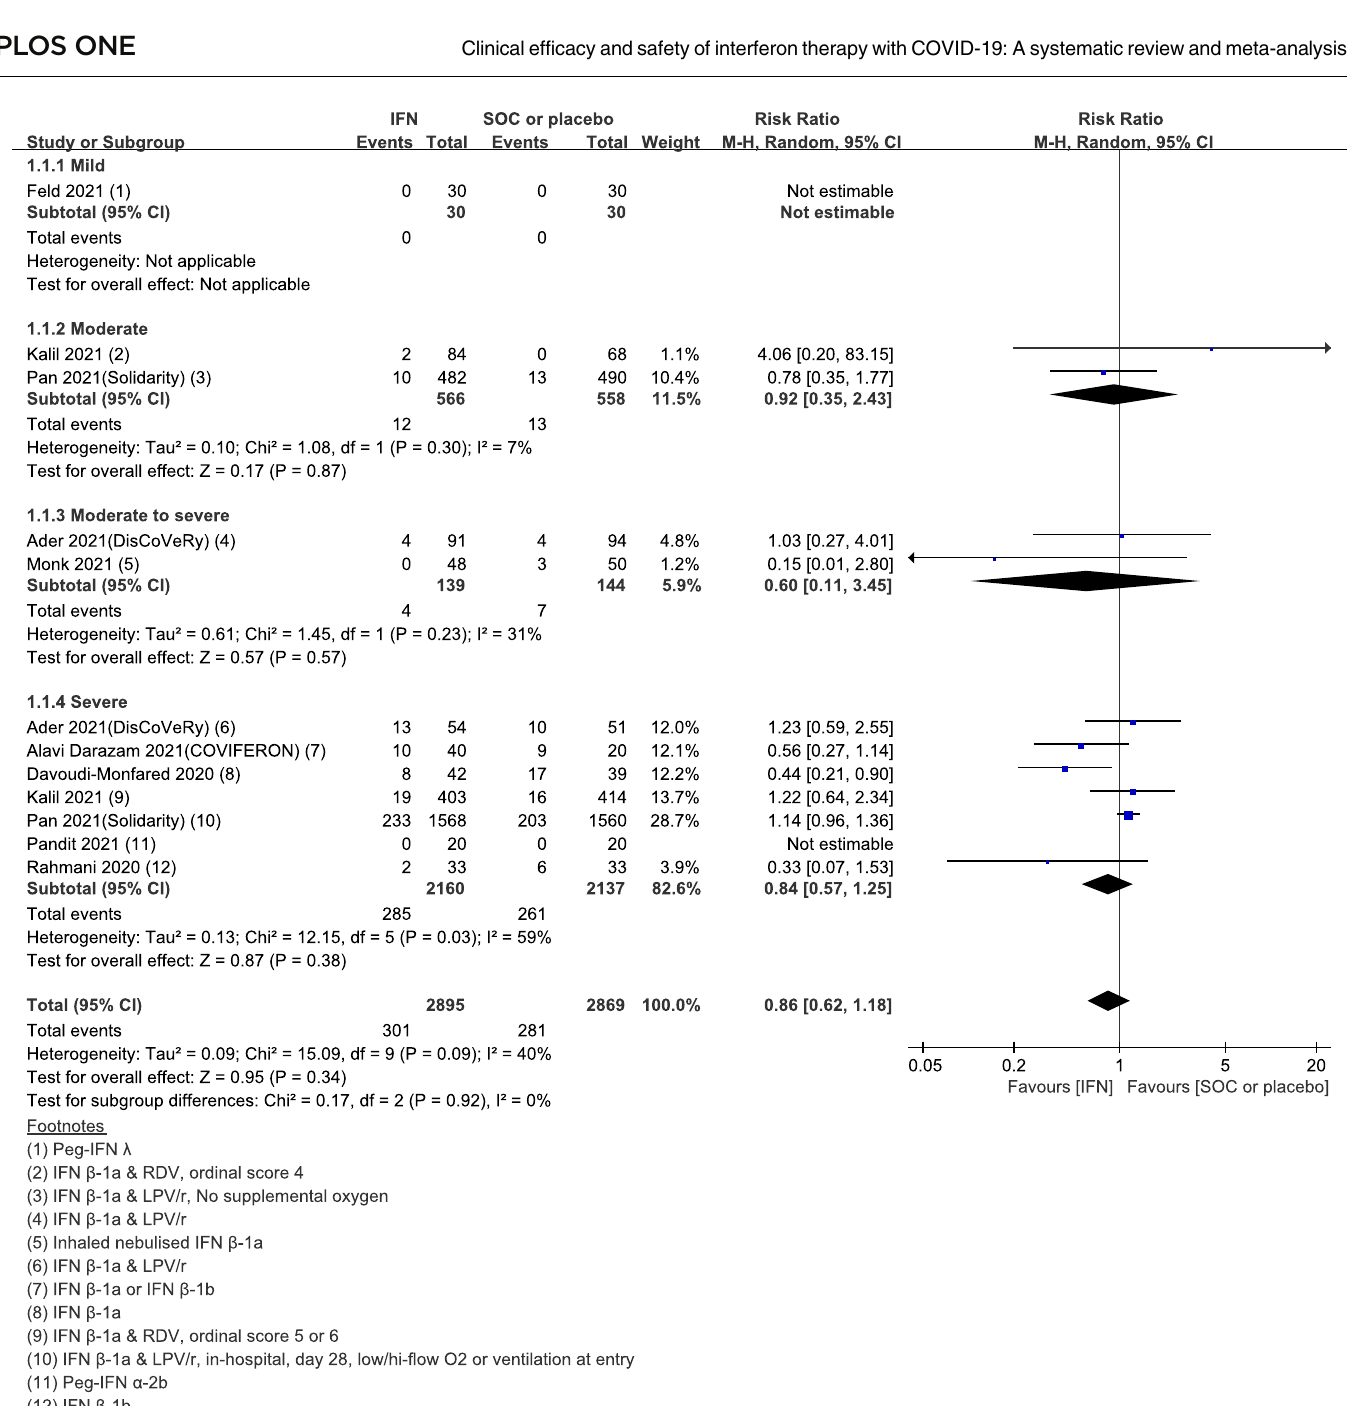
Fig 2. Forest plot of 28-day mortality. Forest plot presenting the risk ratio (RR) for mortality between the interferon (IFN)-treated and control arms. Meta-analysis of nine randomized controlled trials (RCTs) comprising 5,764 patients revealed that IFN therapy failed to reduce 28-day mortality compared to the control arm, regardless of clinical severity (overall group, pooled RR = 0.86, 95% CI: 0.62–1.18, I 2 = 40%; mild group, not estimable; moderate group, pooled RR = 0.92, 95% CI: 0.35–2.43; I 2 = 7%; moderate-to-severe group, pooled RR = 0.60, 95% CI: 0.11–3.45, I 2 = 31%; severe group, pooled RR = 0.84, 95% CI: 0.57–1.25, I 2 =